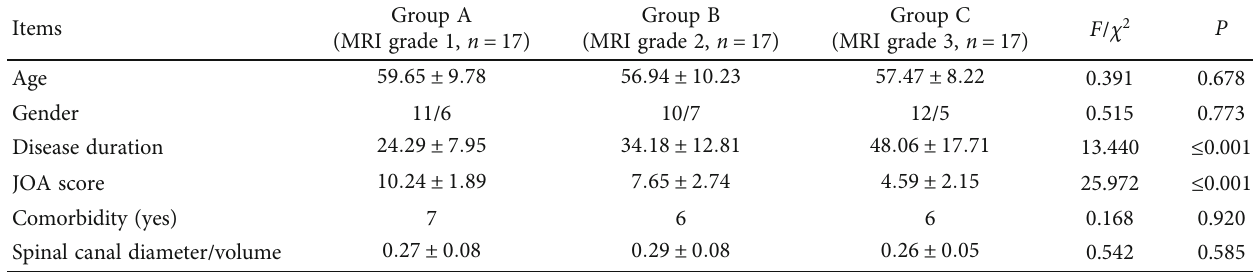
Table 1: Analysis of the general information of the patients in each group.